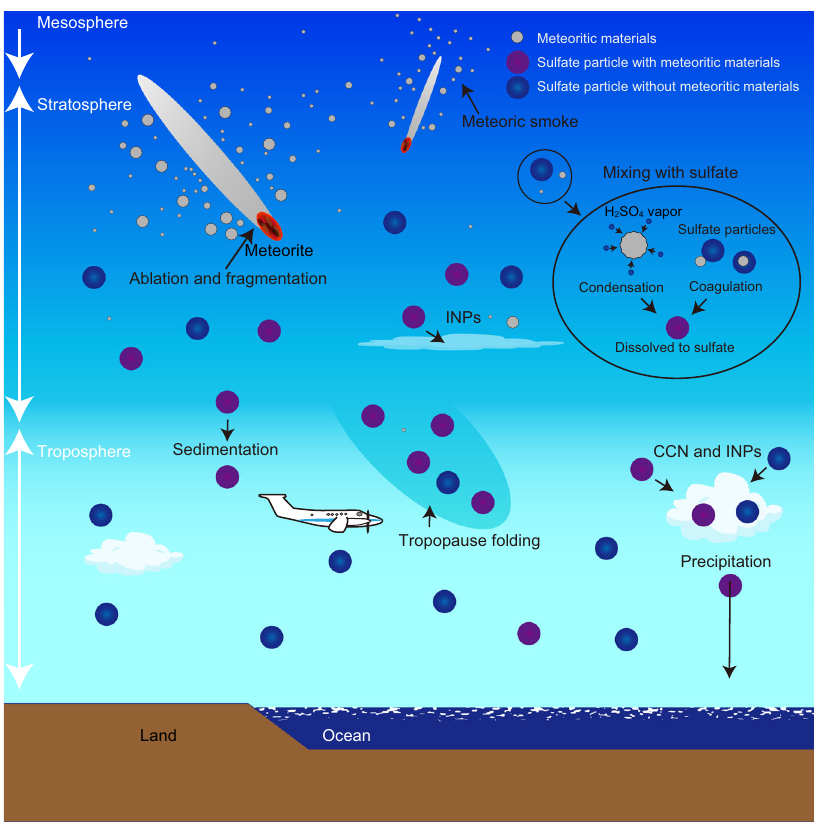
Fig. 8 Schematic illustrating of the fate of meteoritic materials. Gray, purple, and blue spheres indicate meteoritic materials, sulfate particles with meteoritic materials, and sulfate particles without meteoritic materials,